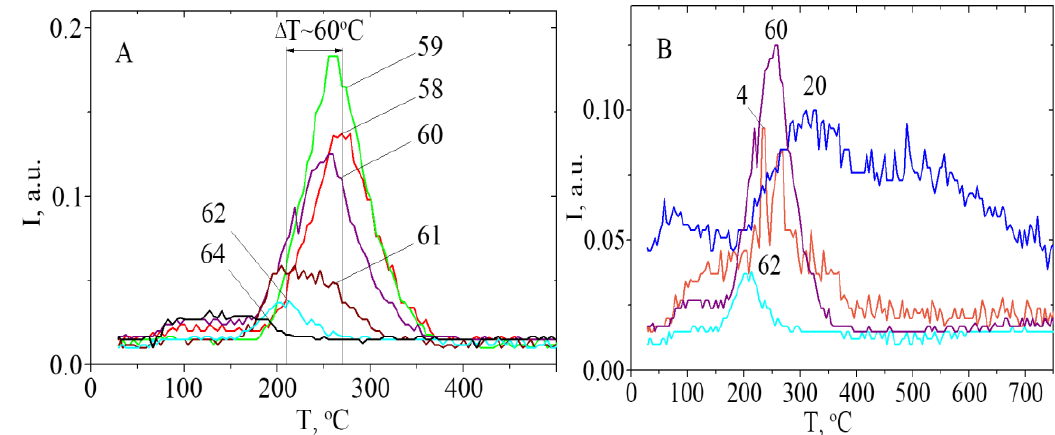
Figure 3. ( A ) TPD curves for the ions of acetone isotopomers with m/z = 64, 62, 61, 60, 59, 58; ( B ) TPD curves for the ions of acetone isotopomers with m/z = 62, 60; TPD curves for the ions of D 2 O + with m/z = 20 for the ions of D 2+ with m/z = 4 were obtained during the pyrolysis of CD 3 COOH on the hCeSi surface.